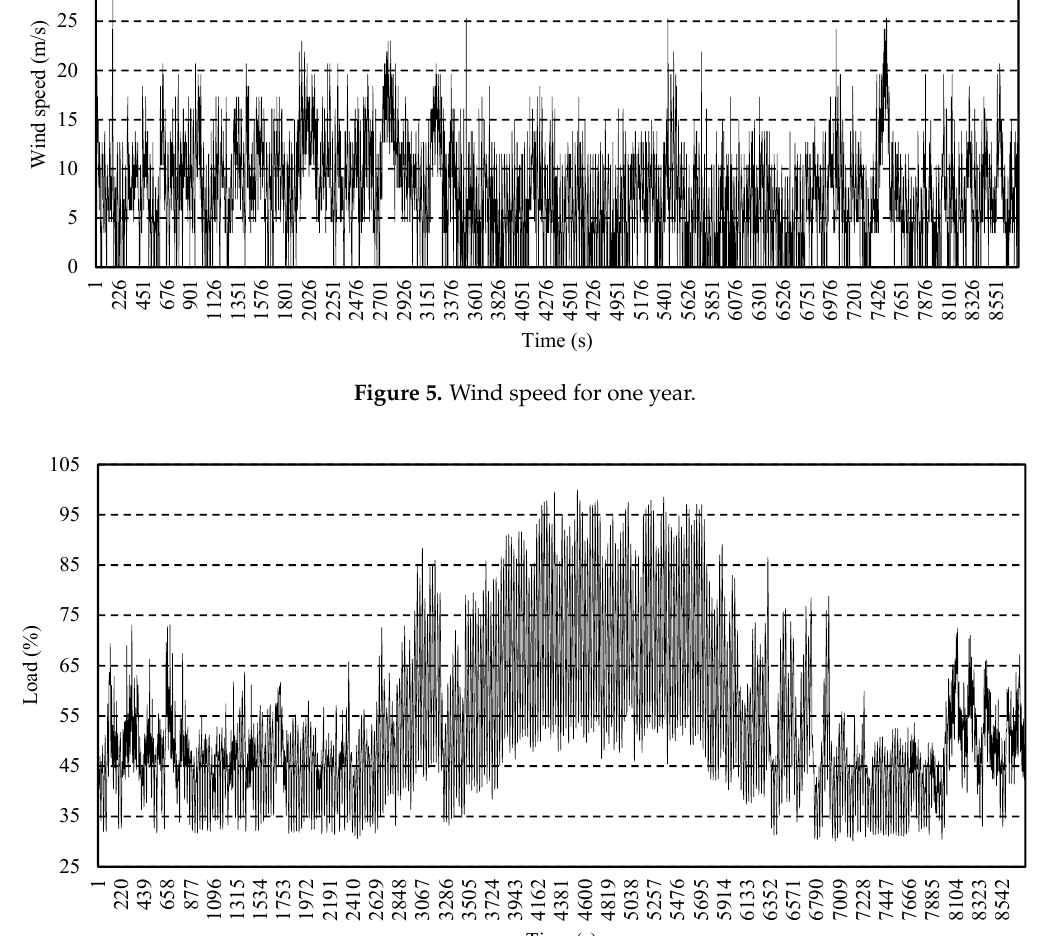
Figure 6. Load profile for one year. Table 1. Wind speed, solar irradiance, and load scenarios.